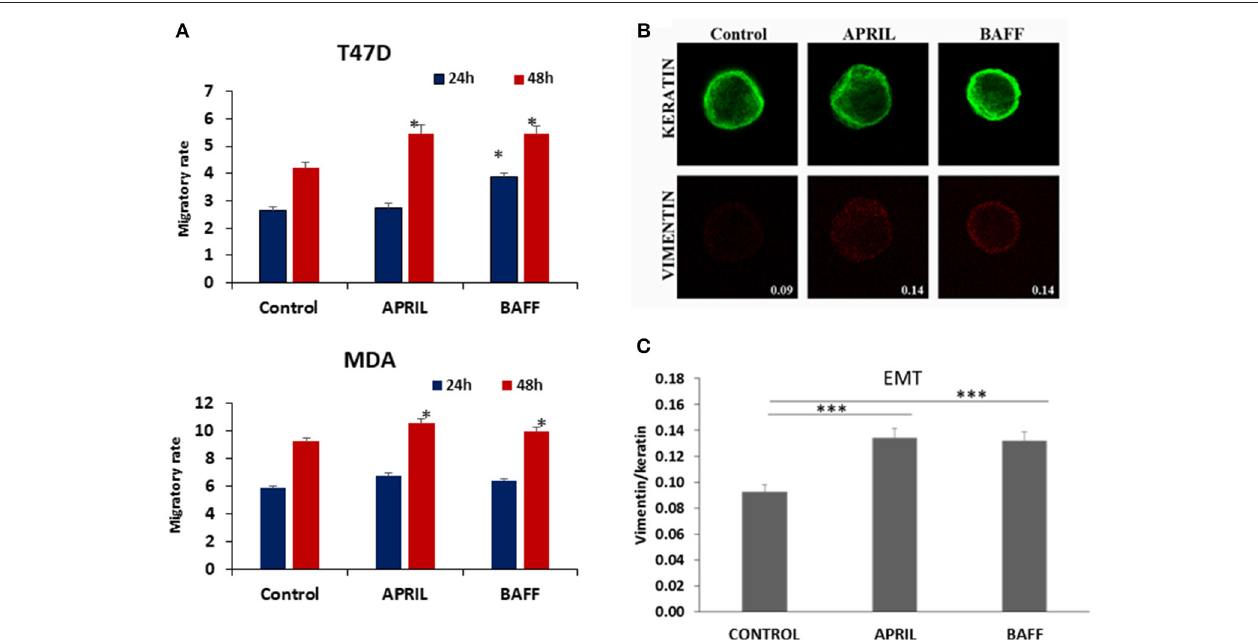
FIGURE 2 | Effect of APRIL and BAFF on migration and EMT status . (A) Effect of APRIL and BAFF (100ng/ml) on migration of T47D and MDA cells after 24–48h of treatment. Figure presents mean ± SE of three independent experiments. (All samples were analyzed with t -test comparing at each time point, treatment vs. control, and *denotes p < 0.05) (B) . Representative photos (Magnification 1000x) of control (untreated) T47D cells and APRIL or BAFF (100ng/ml) treated cells for 4 days immunostained in suspension for keratins (upper panel, green) and vimentin (lower panel, red). Fluorescence intensity was calculated using Image J. Values represent the ratio of vimentin/keratins expression in these cells. (C) Graphical presentation of EMT status changes obtained by calculating the ratio of vimentin/keratins expression of 50 cells for each treatment condition. All samples were analyzed with t -test (*** denotes p <